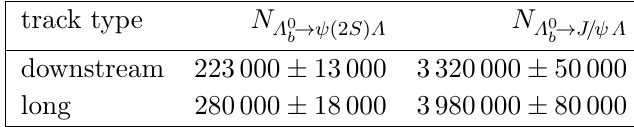
Table 2 . E(cid:14)ciency-corrected yields of (cid:3) 0 the weighted invariant mass for both track